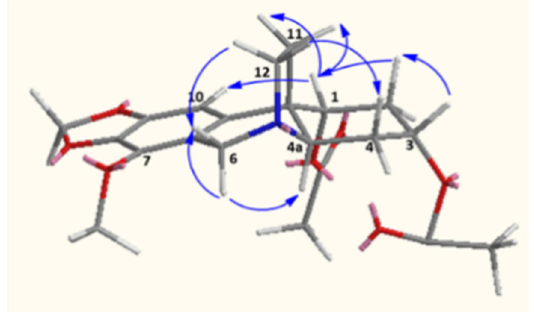
Figure 3. Important NOESY correlations of compound 2 .